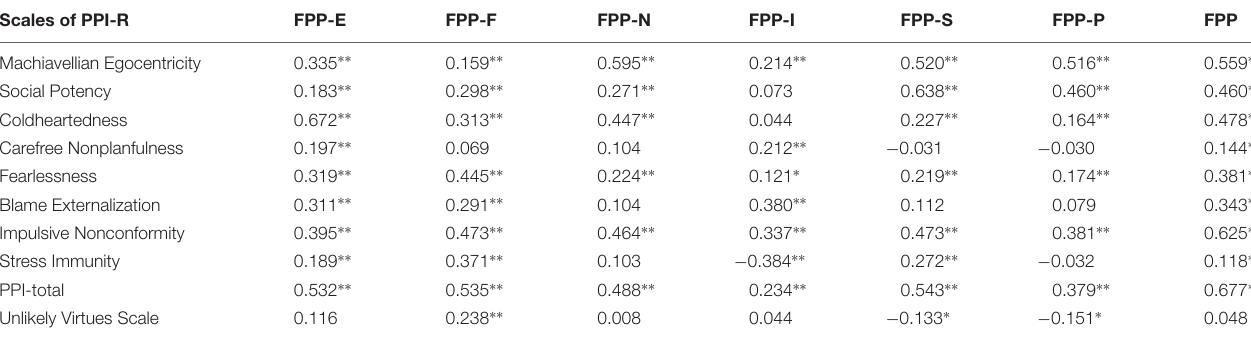
TABLE 5 | Correlations between FPP and PPI subscales (n from 276 to 300). Scales of PPI-R